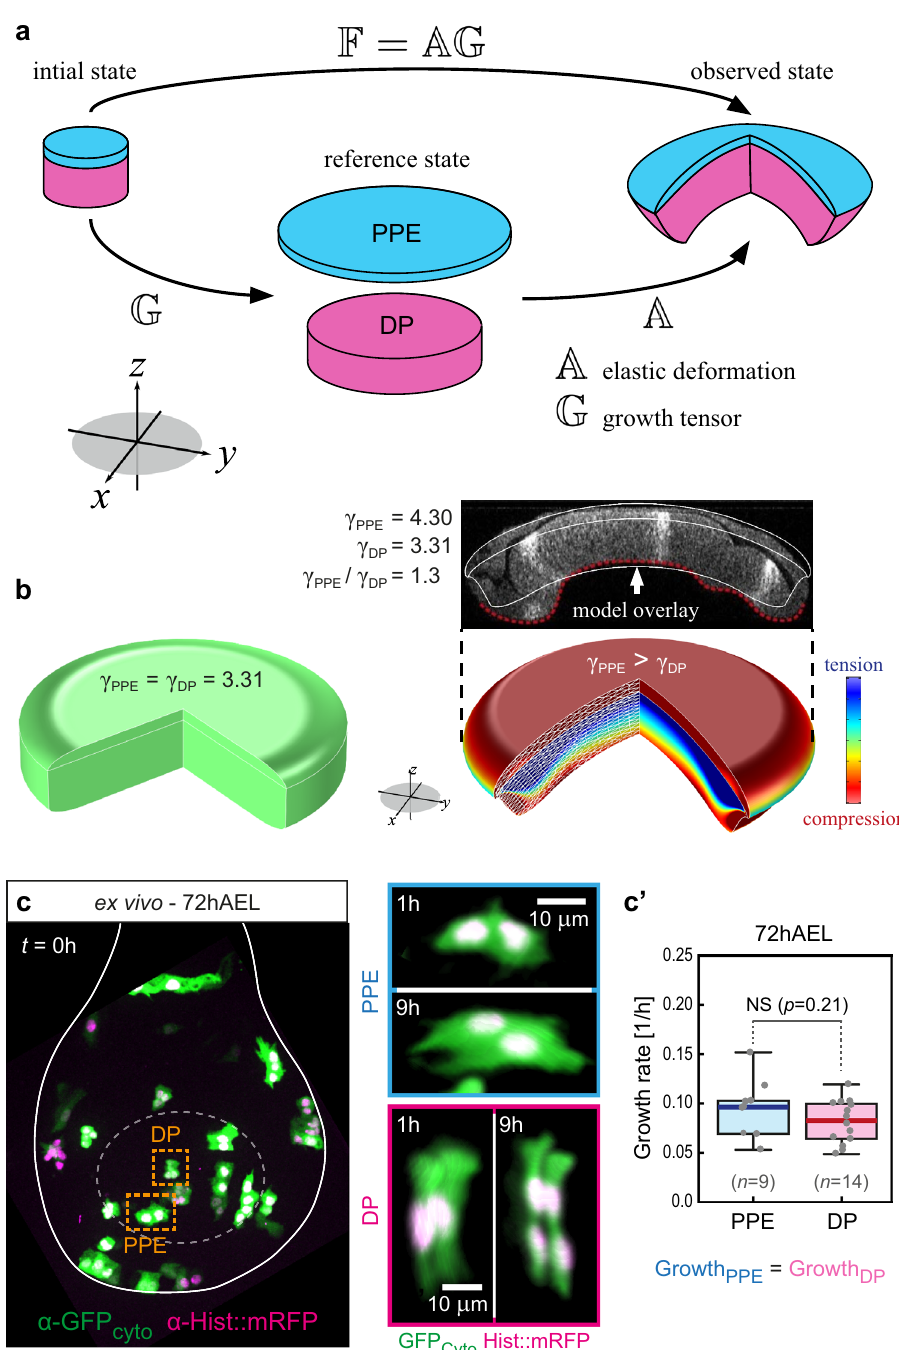
Fig. 2 | Non-uniform growth between epithelial layers does not drive tissue bending. a Geometric decomposition of the wing disc as a sandwich of growing elastic layers, the PPE (blue) and the DP (magenta), each growing uniformly in- plane.Thegrowthtensor G describesgrowthwithoutstress;differentgrowthrates in the respective layers lead to different sizes of the individual discs. Elastic deformation(describedby A )connectsthediscsintoonecoherentobject,leading to the observed morphology and accumulation of residual stress. b Left: if the growth rates in all layers are equal ( γ DP = γ ECM in Eq. (1)), growth is compatible, leading to no residual stress (green colour). Right: if the PPE volume grows ~70% times faster than the DP, simulations approximate well the curvature and